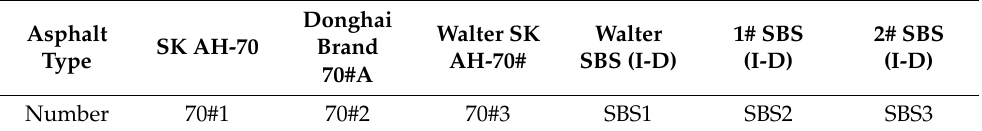
Table 1. Type of different asphalts.